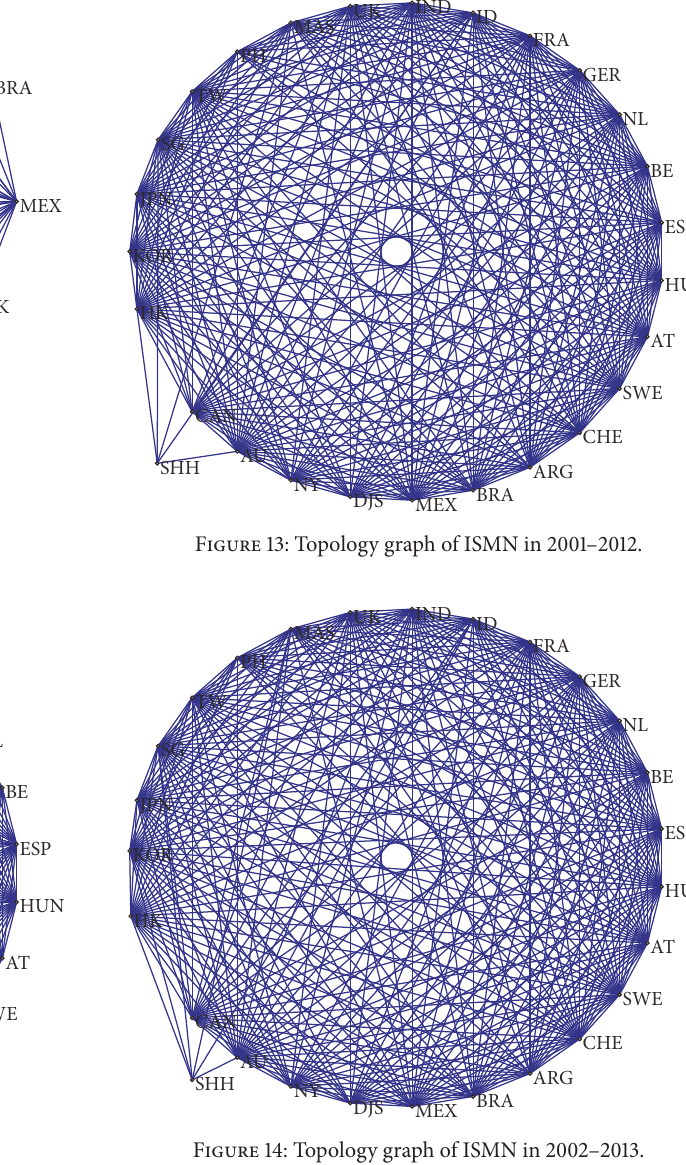
Figure 12: Topology graph of ISMN in 2000–2011.